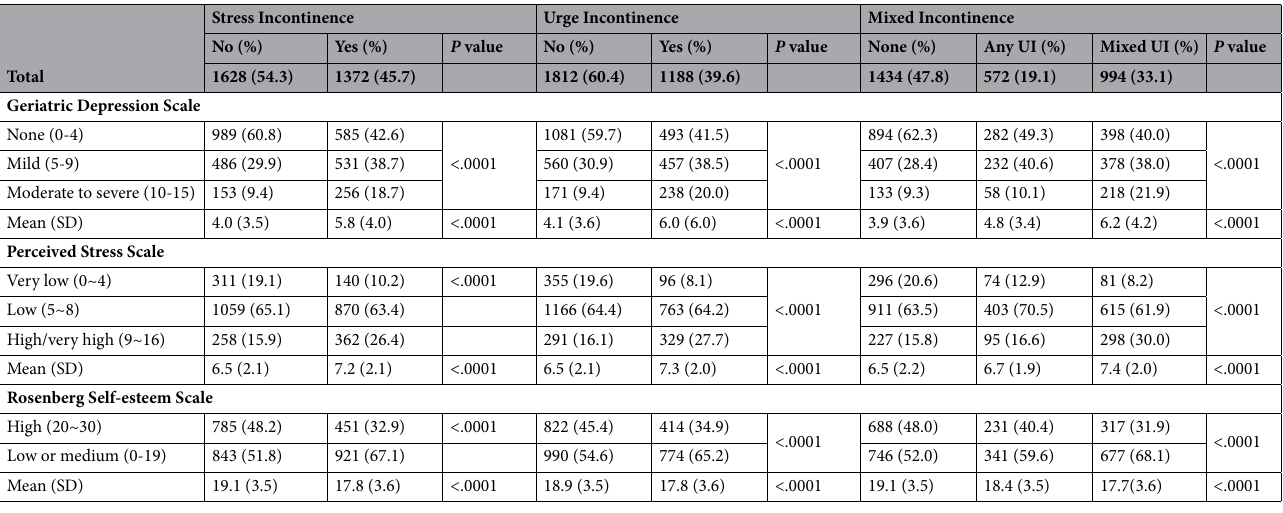
Table 2. Depression, stress, and self-esteem levels according to type of urinary